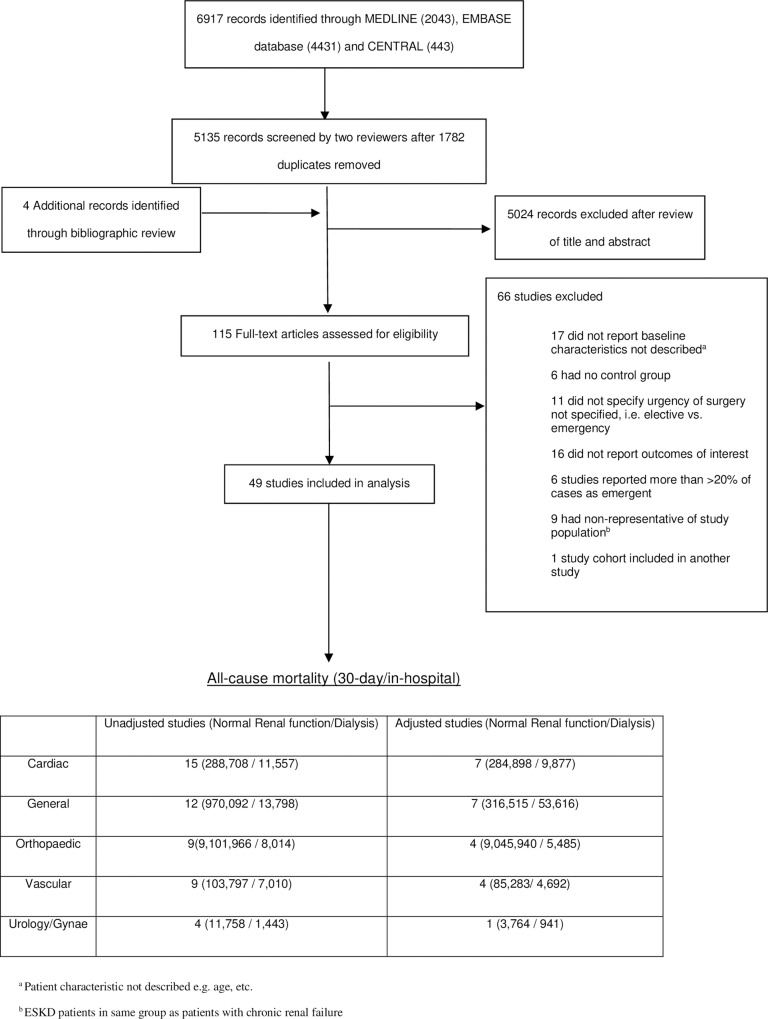
Study selection.